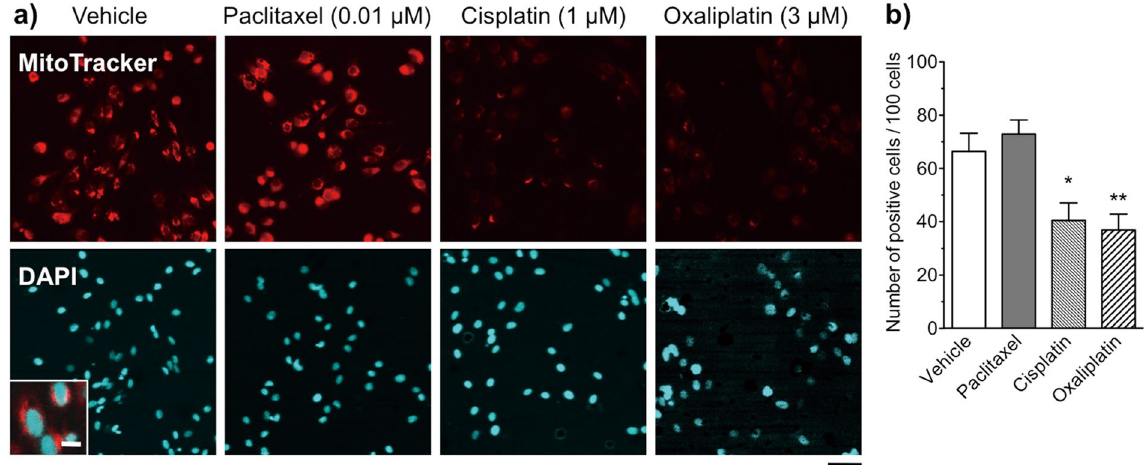
Figure 5. Changes in mitochondrial activity in Schwann cells after treatment with paclitaxel, cisplatin or oxaliplatin. ( a ) Fluorescence micrographs of Schwann cells labeled with the MitoTracker probe (red) and DAPI (blue). Schwann cells were treated with vehicle (0.1% DMSO), paclitaxel (0.01 μ M), cisplatin (1 μ M) or oxaliplatin (3 μ M) for 48 h. Scale bar: 50 μ m (10 μ m in enlarged images) in the vehicle-treated group. ( b ) Number of mitochondria-labeled cells per 100 DAPI-positive cells. The intensity and number of fluorescently labeled mitochondria were reduced after treatment with either cisplatin or oxaliplatin, but not after treatment with paclitaxel. Each column represents the mean ± S.E.M. n = 12. * p < 0.05 and ** p < 0.01 vs . the vehicle- treated